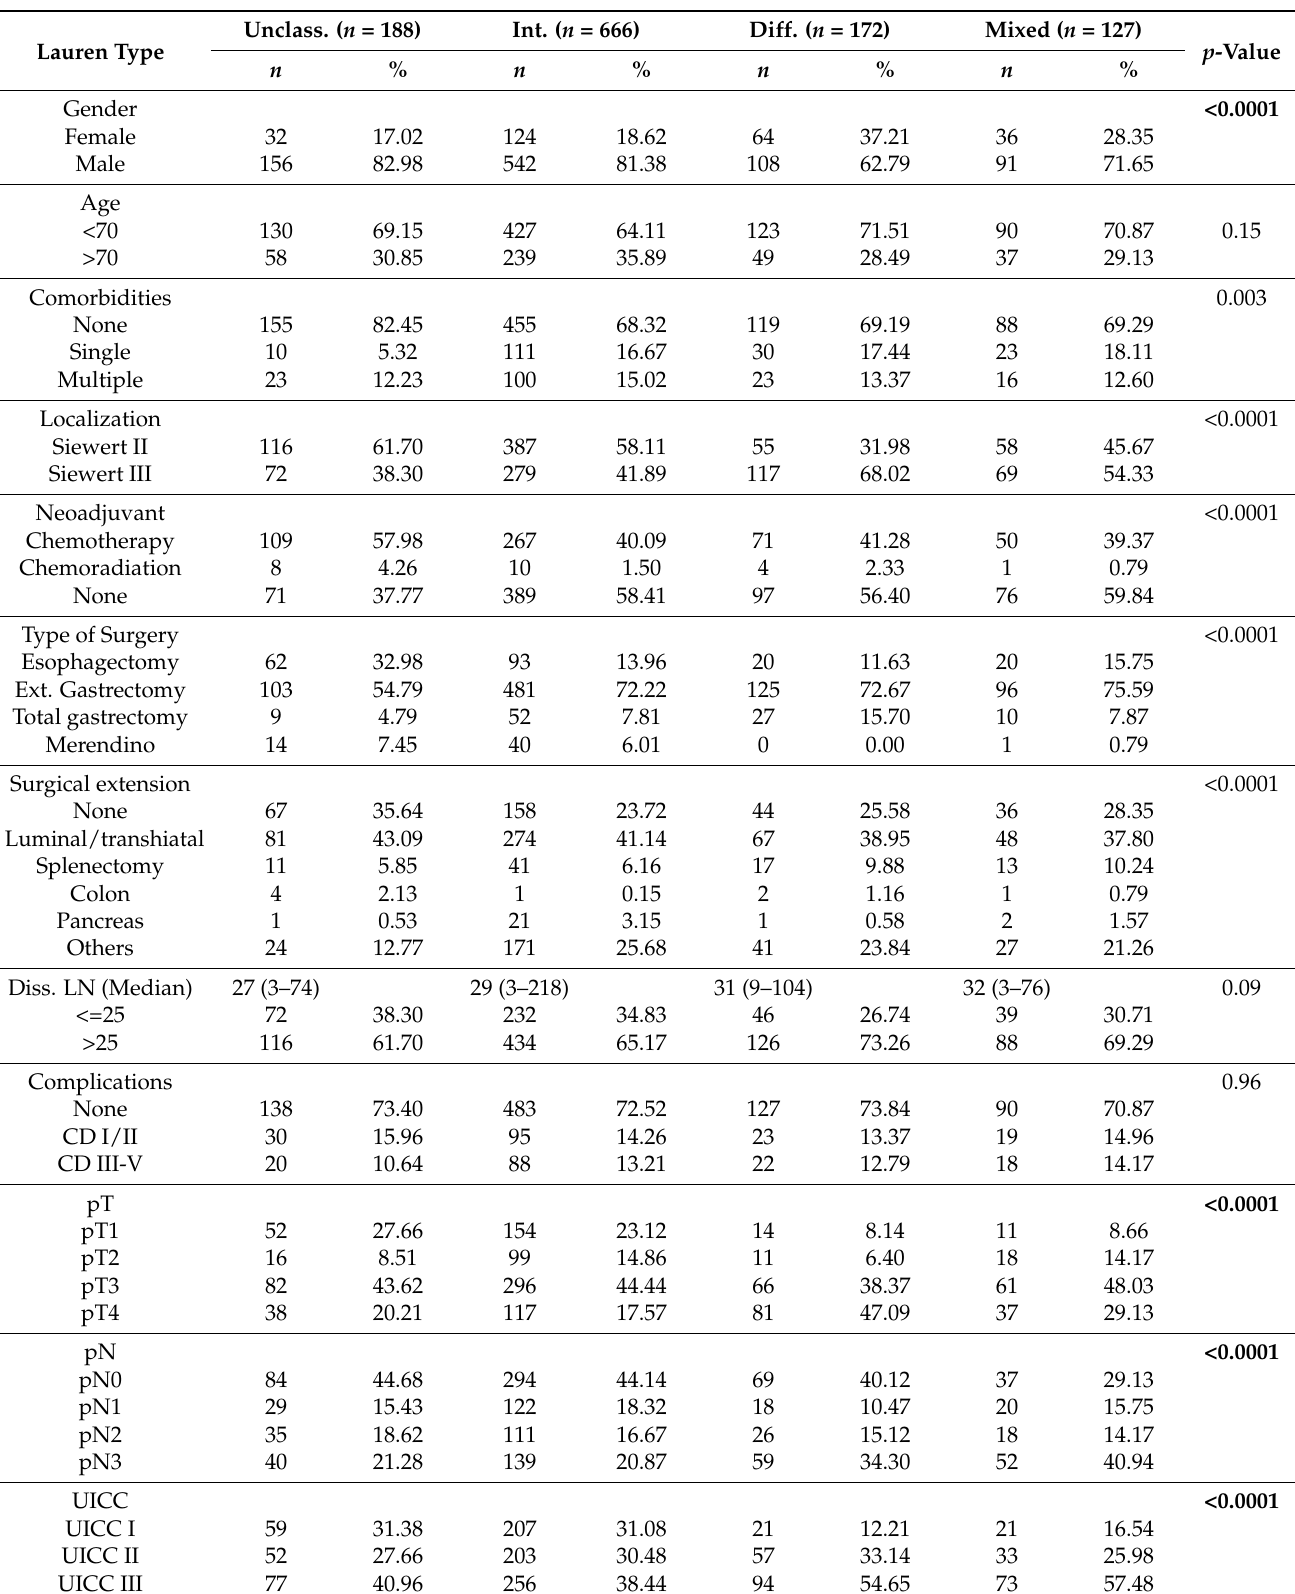
Table 1. Baseline characteristics for patients with respective Lauren subtypes before propensity score matching (PSM). Lauren